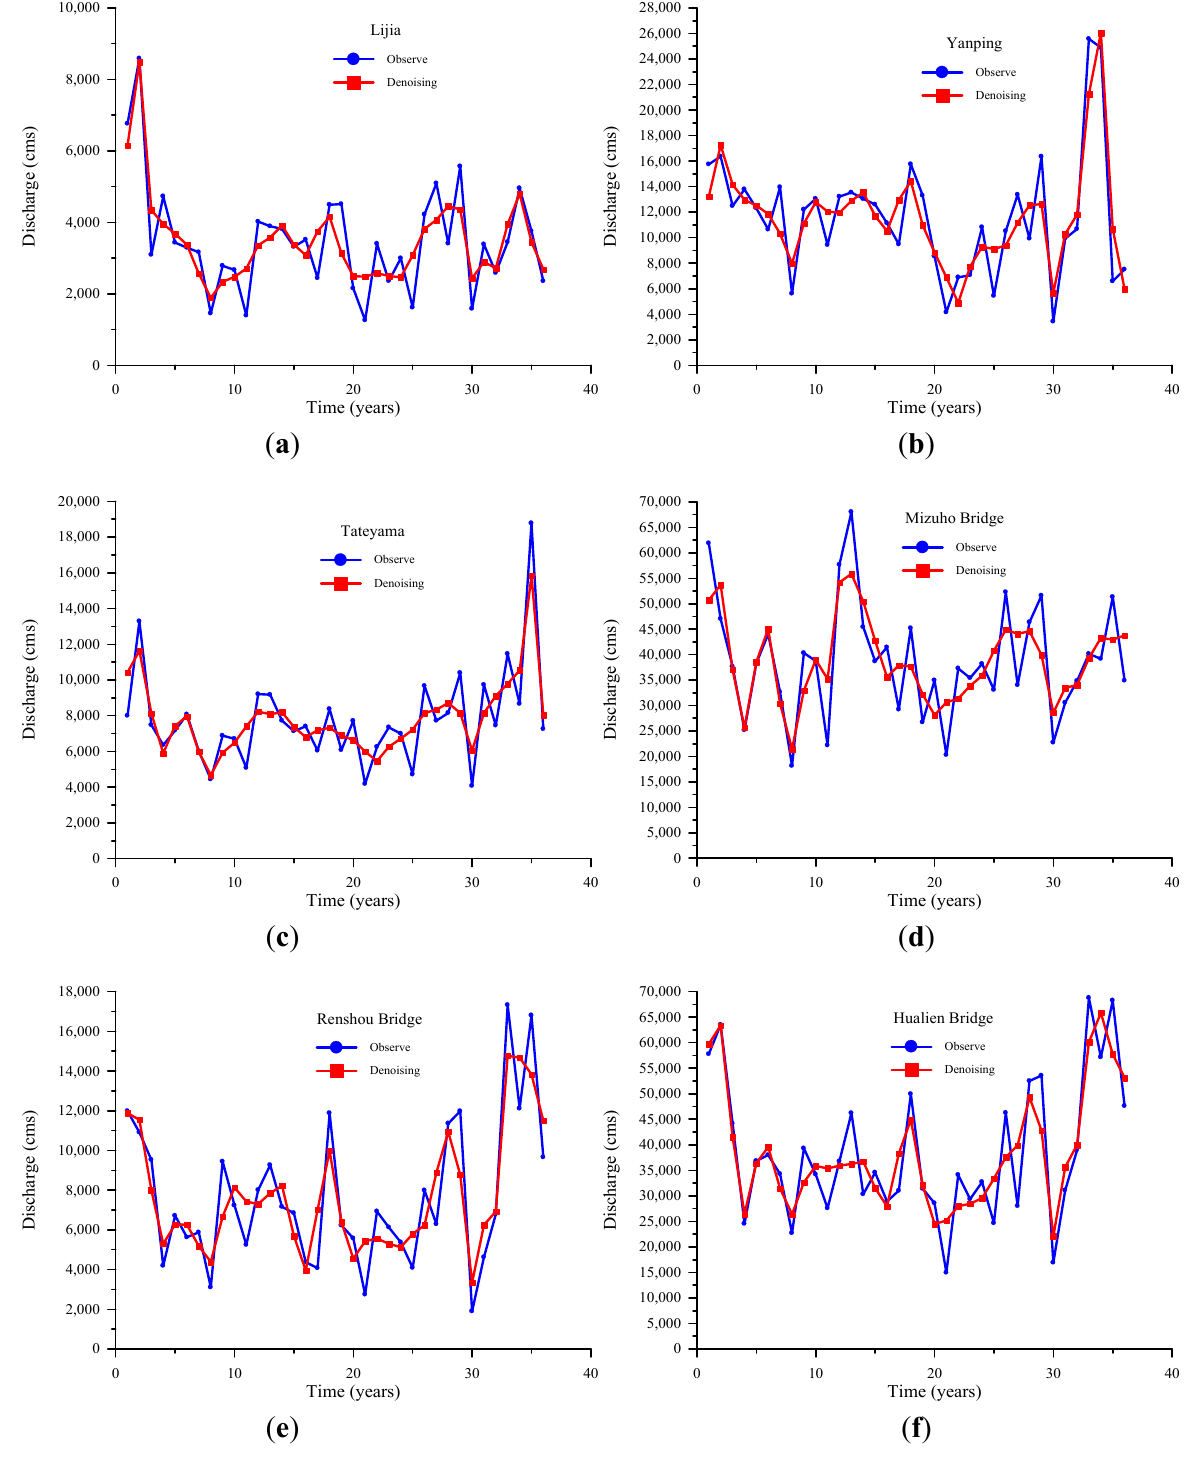
Figure 3. Original annual runoff time series and denoised annual runoff time series using wavelet denoising of the six stations. ( a ) Lijia Station; ( b ) Yanping Station; ( c ) Tateyama Station; ( d ) Mizuho Bridge Station; ( e ) Renshou Bridge Station; ( f ) Hualien Bridge